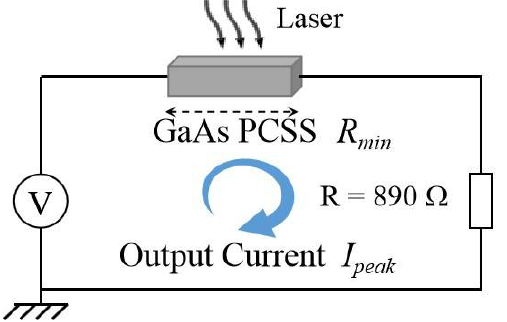
Figure 7. Equivalent circuit of the GaAs PCSS triggered by a laser.